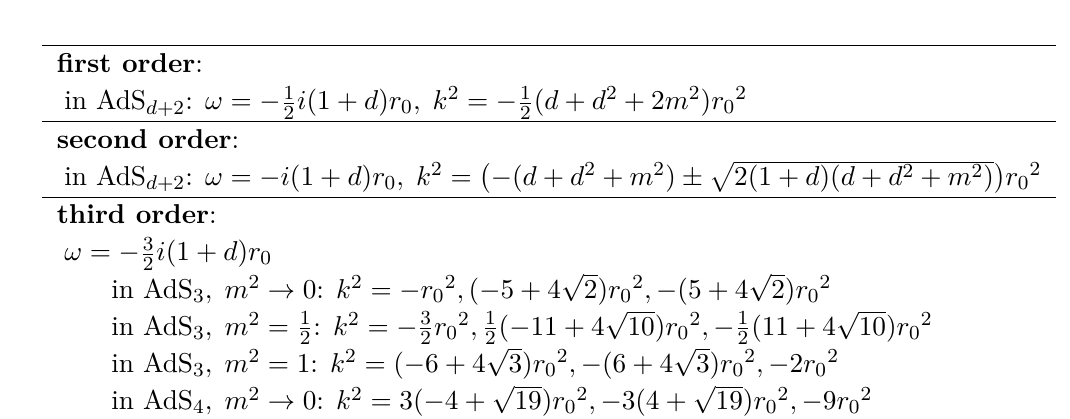
Table 3 . Pole-skipping analytics for the massive temporal mode.